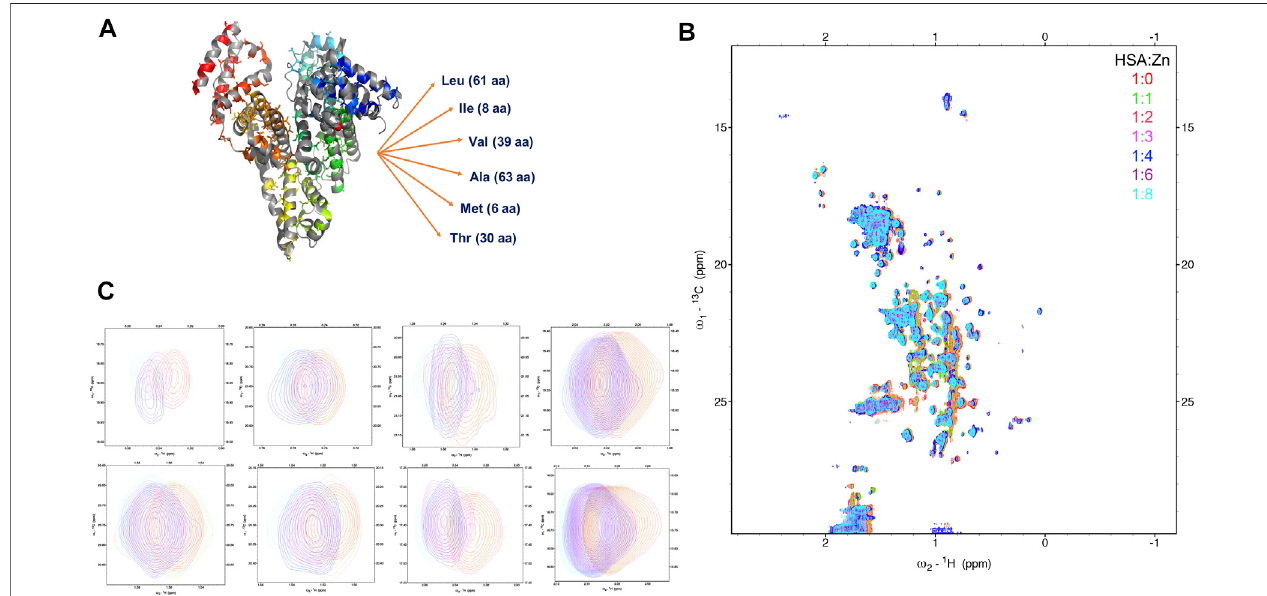
FIGURE 3 | Monitoring the Zn(II) ions binding to HSA with natural abundance of 13 C at atomic resolution. The 2D [ 1 H- 13 C] SOFAST methyl-TROSY spectrum of HSA titrated with increasing ratio of Zn(II). (A) Structure of HSA in Zn(II) bound state highlighting 207 Methyl groups on six amino acids side chains LIVAMT. (B) the 2D Methyl-TROSY spectrum of free HSA (red) overlaid with HSA titrated with different ratios of ZnCl 2 (1:1 (green), 1:2 (pink), 1:3 (magenta),1:4 (blue), 1:6 (purple) and 1:8 (cyan)). (C) Selected peaks showing different behaviors of signals.